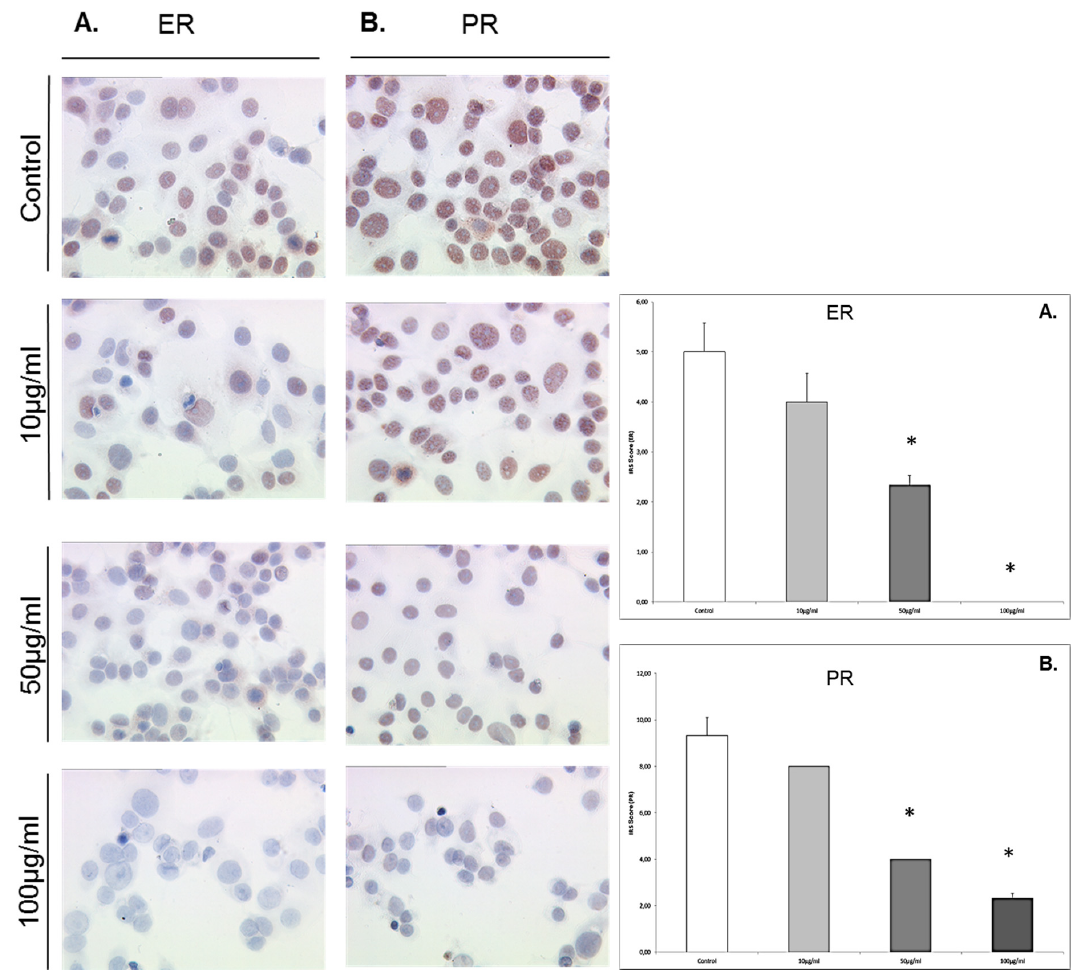
Figure 5. Representative microphotographs of MCF7 cells grown in the absence or presence of enterolactone at concentrations of 10 μ g/mL, 50 μ g/mL, and 100 μ g/mL), after immuno ‐ detection of ER ‐α ( A ) and PR ( B ); and presentation of the immunocytochemistry results by the semi ‐ quantitative immunoreactivity score (IRS). Significantly different observations are highlighted with an asterisk. 3.6. Enterodiol Downregulates Expression of ER α and PR Only at High Concentrations in MCF7 Cells MCF7 cells that were exposed to enterodiol at concentrations of 10 μ g/mL, 50 μ g/mL, and 100 μ g/mL responded with a significant downregulation of ER α only at 100 μ g/mL (IRS score 0) compared to the control (IRS score 5, p = 0.023) (Figure 6). MCF7 cells that were exposed to enterodiol at concentrations of 10 μ g/mL, 50 μ g/mL, and 100 μ g/mL responded with a significant downregulation of the PR at 100 μ g/mL (IRS score 0) compared to the control (IRS score 5.5, p = 0.023).